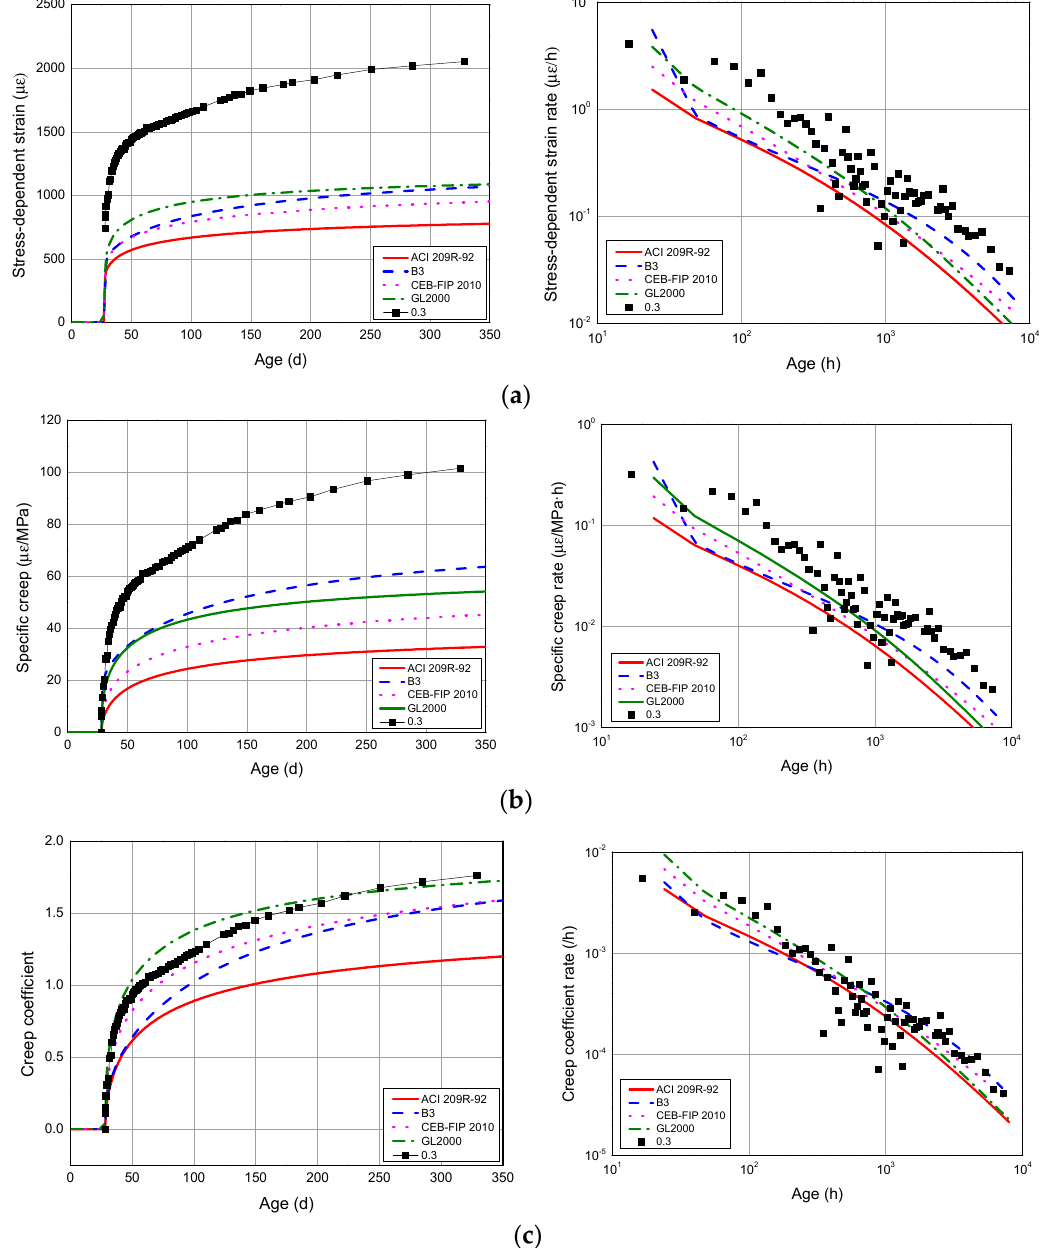
Figure 8. Comparison of creep in AAS concrete based on the model predictions. ( a ) stress-dependent strain; ( b ) specific creep; ( c ) creep coefficient.